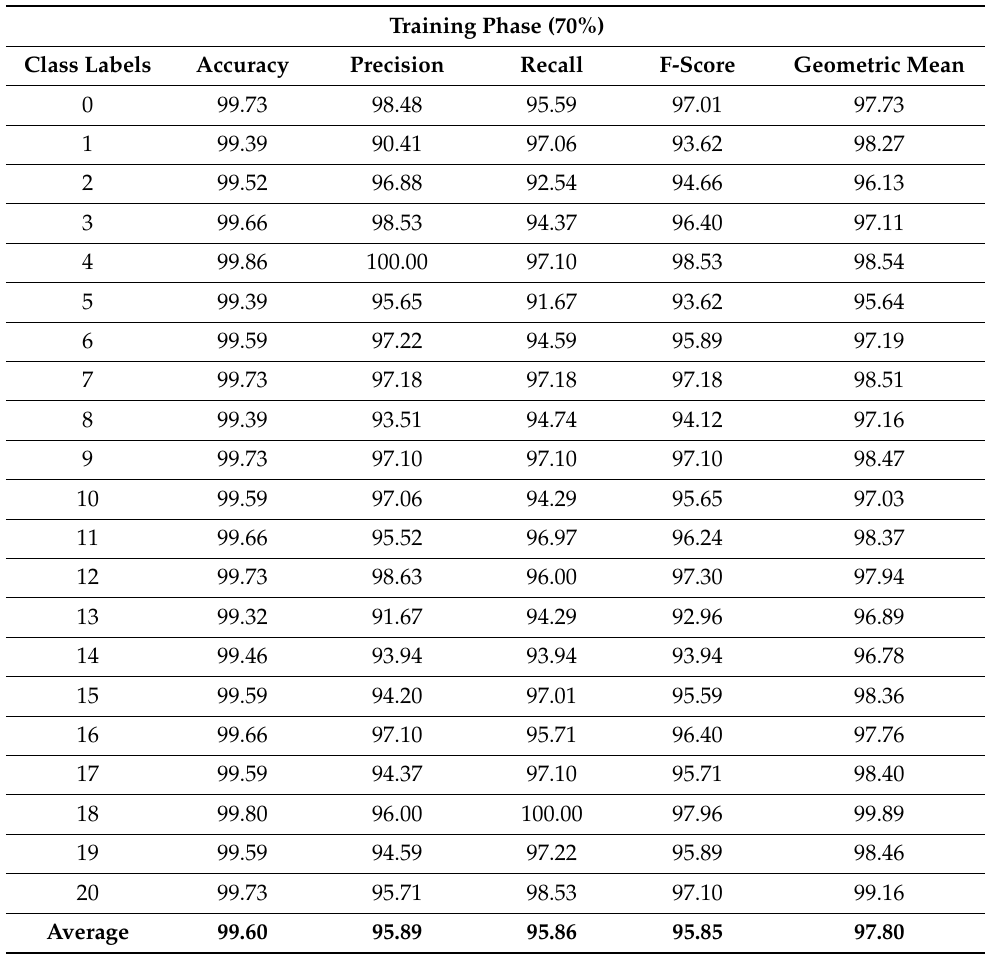
Table 1. Result analysis of SIDTLD-AIC technique with various measures on 70% of UCM datasets as training